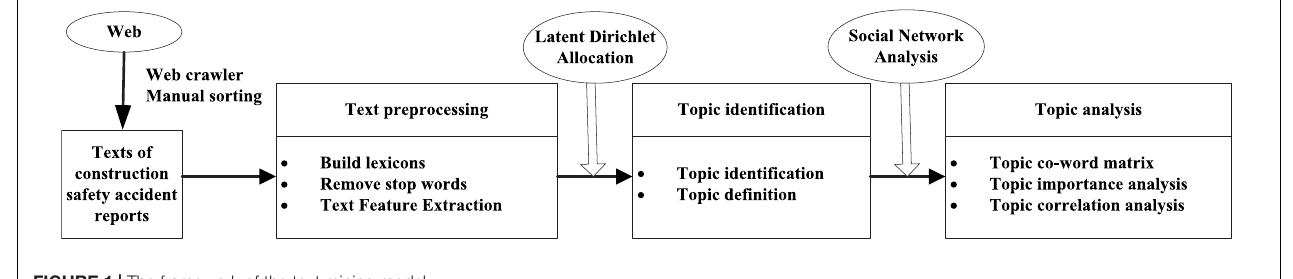
FIGURE 1 | The framework of the text mining